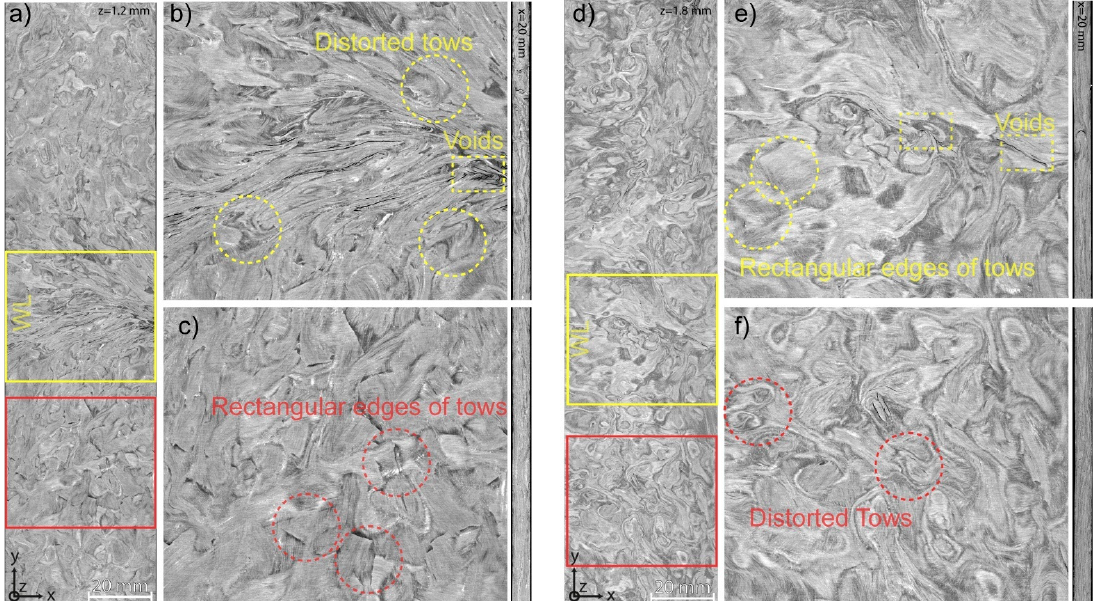
Figure 12. Micro-CT images of ( a ) Flow sample strip, showing two regions: ( b ) weld-line showing high distortion of the tow shapes, ( c ) away from the weld-line the tows with rectangular ends are encircled in c. The slice through is at x = 20 mm. (( d ) Butt sample strip, showing two regions: ( e ) weld-line region where some tows with originals rectangular shape can be seen, ( f ) away from the weld-line high distortion is observed. The slice through is at x = 20 mm, showing the planar behaviour away from the weld-line.